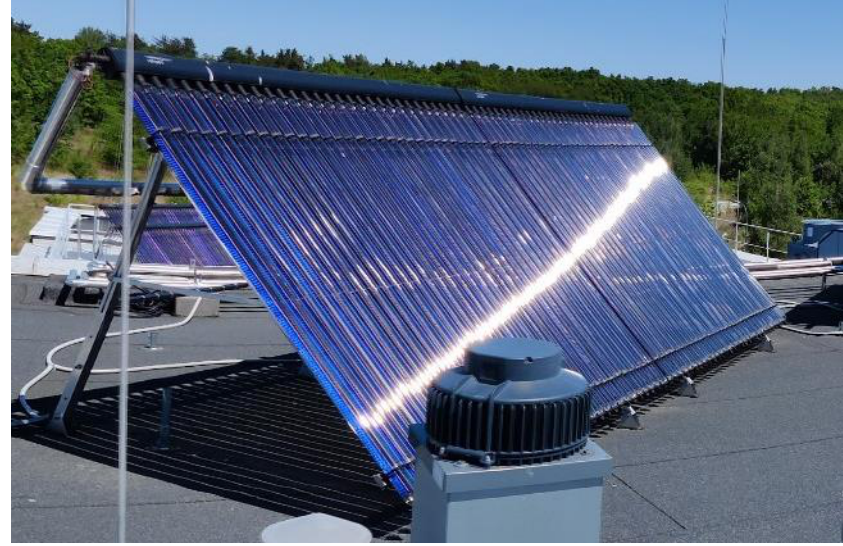
Figure 3. Kingspan Thermomax DF 400- 30-way solar collector (60-way module). The climatic data, i.e., ambient temperature (outdoor temp.) and intensity of solar Table 2. Technical data of Kingspan Thermomax solar collector [37]. Parameter